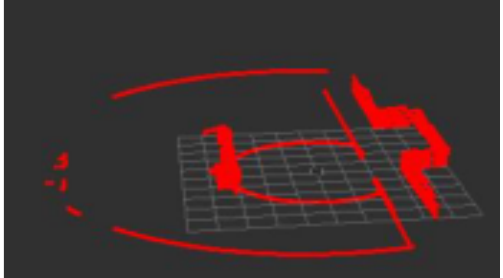
Figure 3. After denoising and desampling.